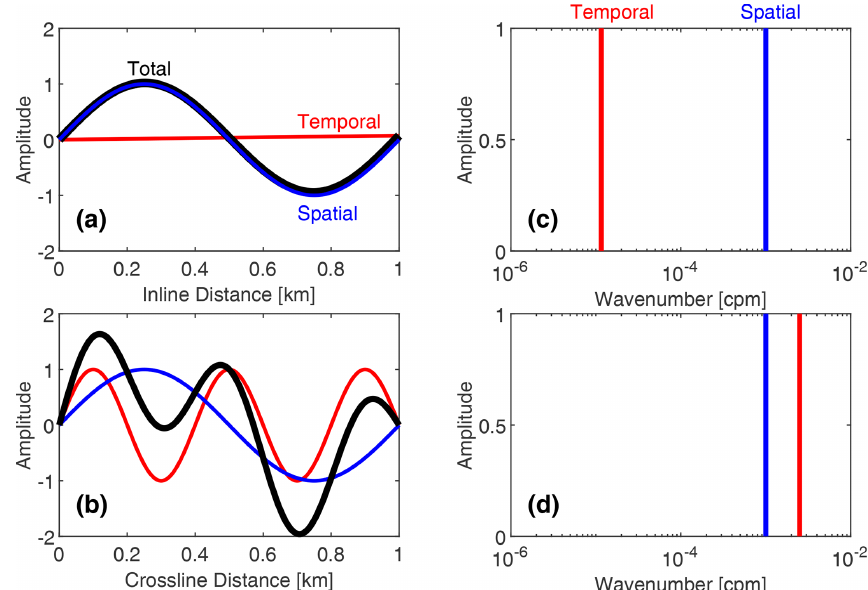
Figure 8. Illustration of temporal (red), spatial (blue), and total (black) variations in inline and crossline directions for a simple water column. (a) In the inline direction, (b) in the crossline direction, (c) spectrum of inline variation, and (d) spectrum of crossline variation. Note that the red line in (c) marked the theoretical position of temporal variations, which may not be resolved due to the short collection period. See Fig. 9a and b for further illustration of deriving inline and crossline variations from a 3D seismic volume.